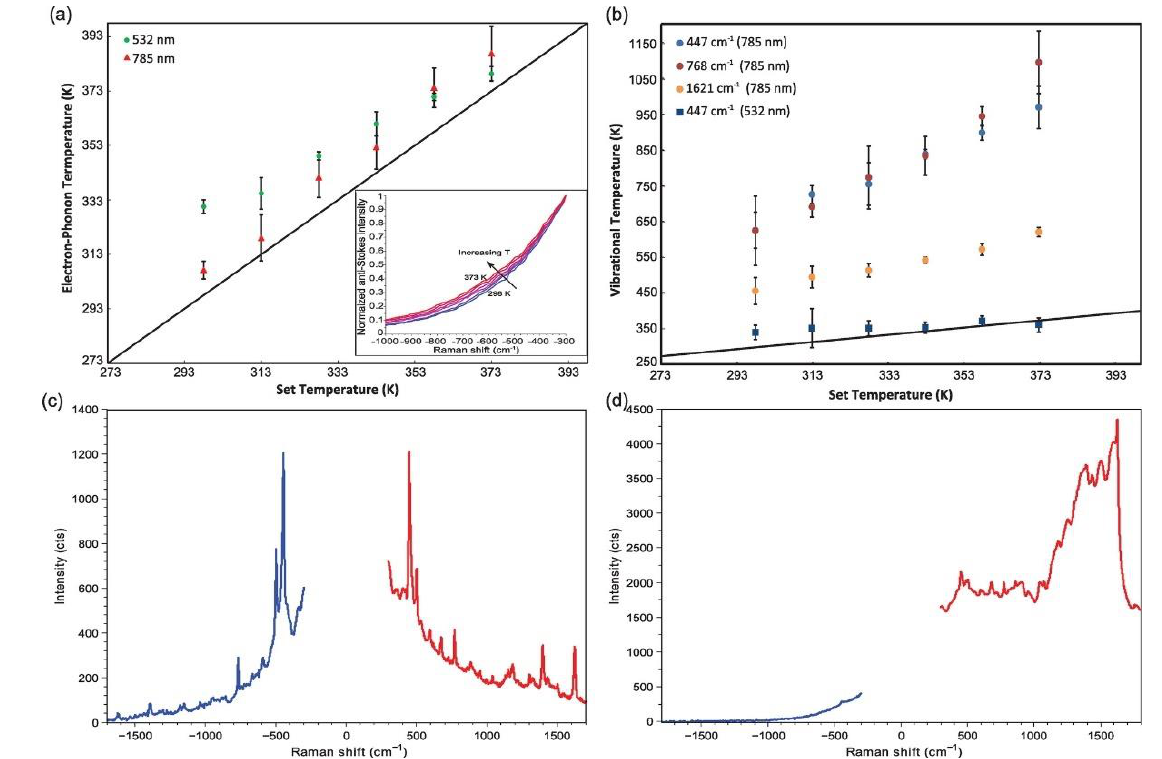
Figure 19. SERS as a probe to measure localized phonon temperatures of metal nanoparticles and vibrational adsorbate temperatures. Linic et al. [117] in ( a ) the temperature of the Ag nanoparticles under illumination by two laser sources (532 nm and 785 nm) are shown. Anti-Stokes spectra for the same is presented in the inset, along with temperatures of prominent vibrational modes of MB adsorbed on Ag ( b ), and the Stokes (red) and anti-Stokes (blue) spectra for the Ag–MB plasmonic system. There is a high anti-Stokes signal under 785 nm laser illumination ( c ) due to resonant charge transfer. The strong elevation in vibrational temperature of the adsorbed MB molecules under 785 nm laser illumination indicates resonant charge transfer from Ag to MB, while the similar temperatures of the Ag and the MB molecule under 532 nm laser illumination ( d ) indicates a lack of charge transfer, and a system in thermal equilibrium. Reprinted with permission from Ref [117] Copyright American Chemical Society (2016).